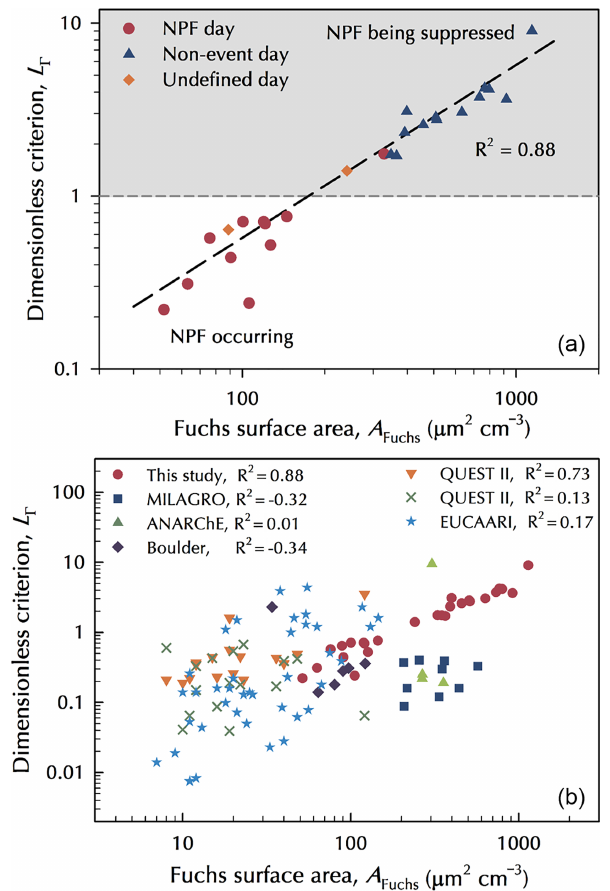
Figure 6. (a) The correlation between L (cid:48) and A Fuchs (data from Table 1) in this campaign. NPF days, non-event days, and undefined days are shown as different symbols. The regression was based on all campaign days. (b) The correlation between L (cid:48) and A Fuchs es- timated for this study in comparison to other campaigns.